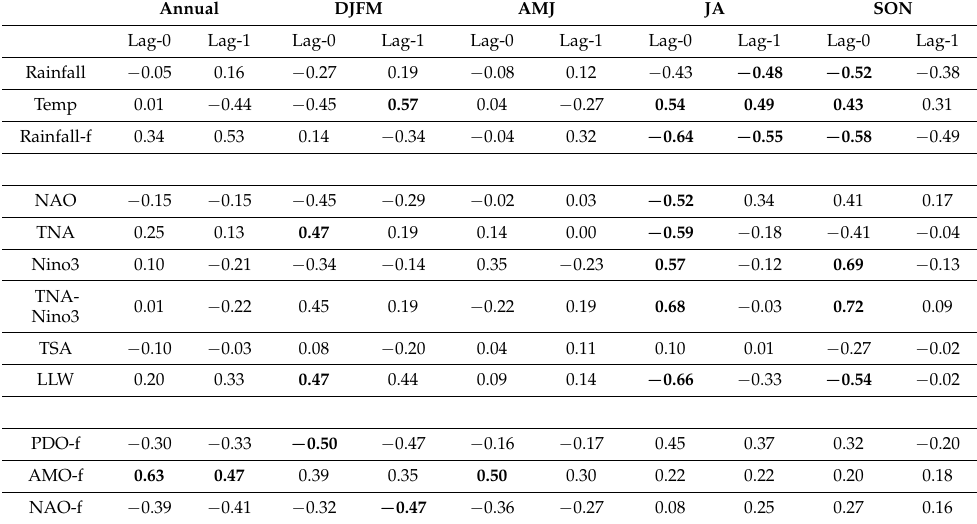
Table 6. Concurrent and lagged correlations between bushfire frequency and climate indices for annual and seasonal periods calculated over 2001–2019. One year/season lags are calculated with climate leading (2000–2018). “ − f” are the low pass filtered components. The correlations with LLW are over 2001–2018. Values in bold are significant at the 95% level.